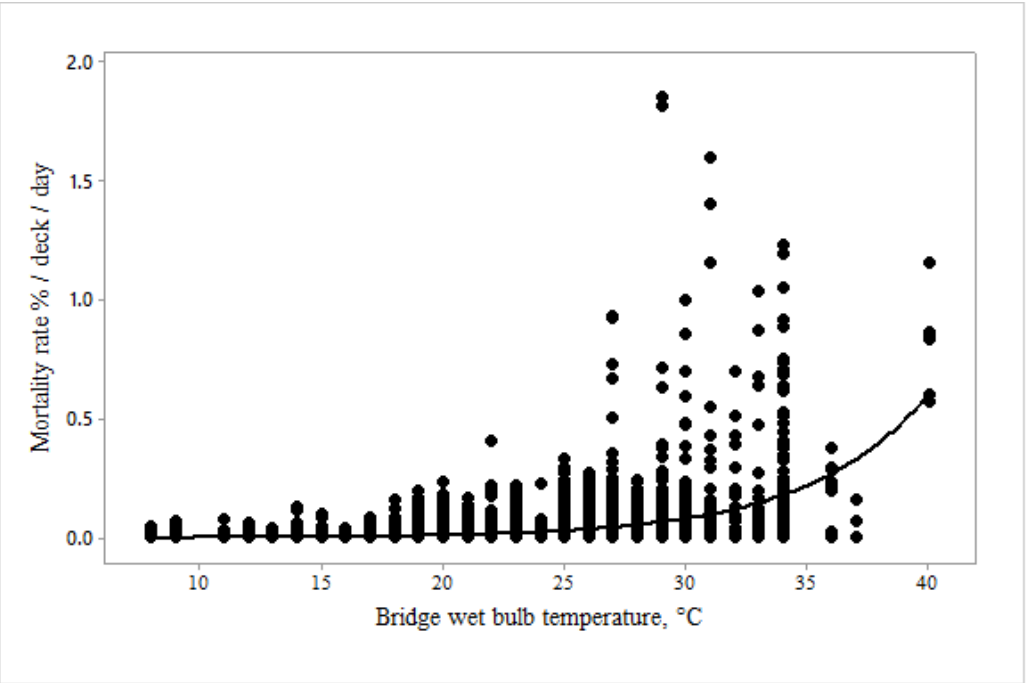
Figure 8. Mortality rate (%/deck/d) changes with bridge wet bulb temperature (°C) ( n = 2798). Animals 2020 , 10 , x FOR PEER REVIEW The relationship between mortality rate %/deck/day and bridge T WB was described by the equation: Mortality rate (%/deck/d) = 0.0002 (±0.00004) × exp 0.2 (±0.007) Bridge T WB , °C, F = 7.66, p < 0.0001 (Equation 6).